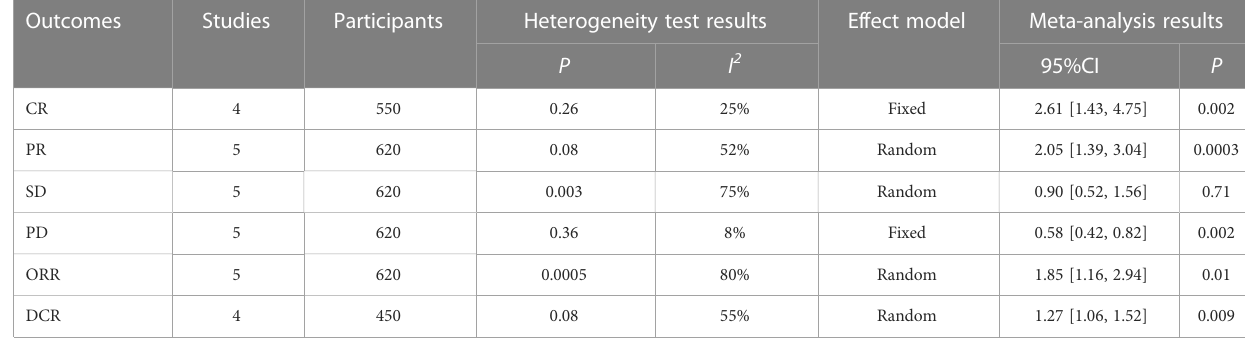
TABLE 2 Response